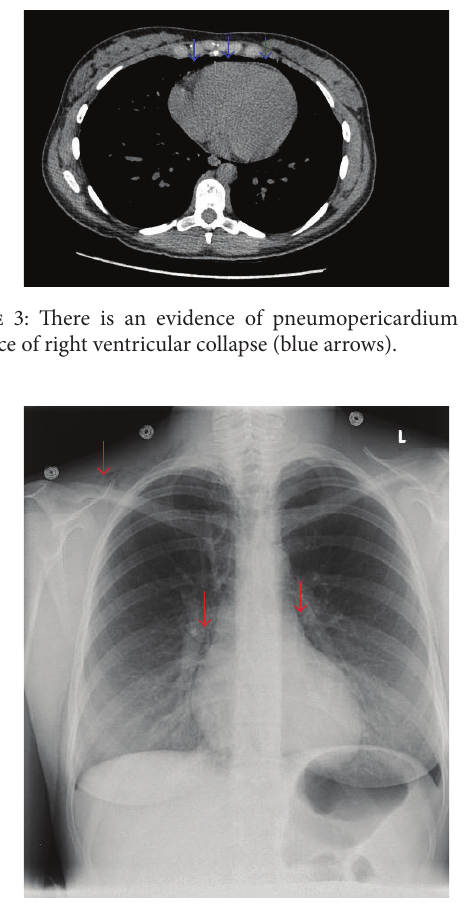
Figure 4: Just prior to discharge, a chest X-ray shows marked improvement in subcutaneous emphysema (red